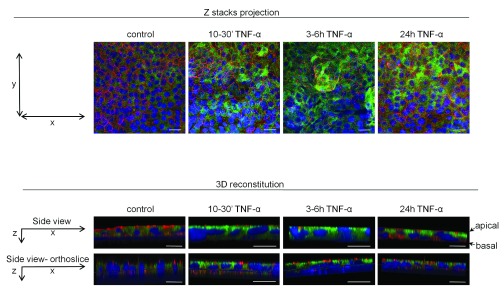
Increased apical localization of F508del-CFTR in primary HBE cell cultures upon treatment with TNFα.Differentiated primary HBE cell cultures grown at an air-liquid interface were incubated with 50ng/ml TNFα for 10–30min, 3–6h and 24h. CFTR immunodetection was performed with 24.1 anti-CFTR antibody and analyzed with confocal microscopy. Green staining represents CFTR (Alexa Fluor 488), red color staining represents ZO-1 protein of tight junctions (Alexa Fluor 594) and blue DAPI staining visualizes nuclei. Independent TNFα treatments and CFTR immunodetection were performed on HBE cells from three different F508del/F508del CF patients. Representative images of one experiment are demonstrated (Scale bars = 20µm).